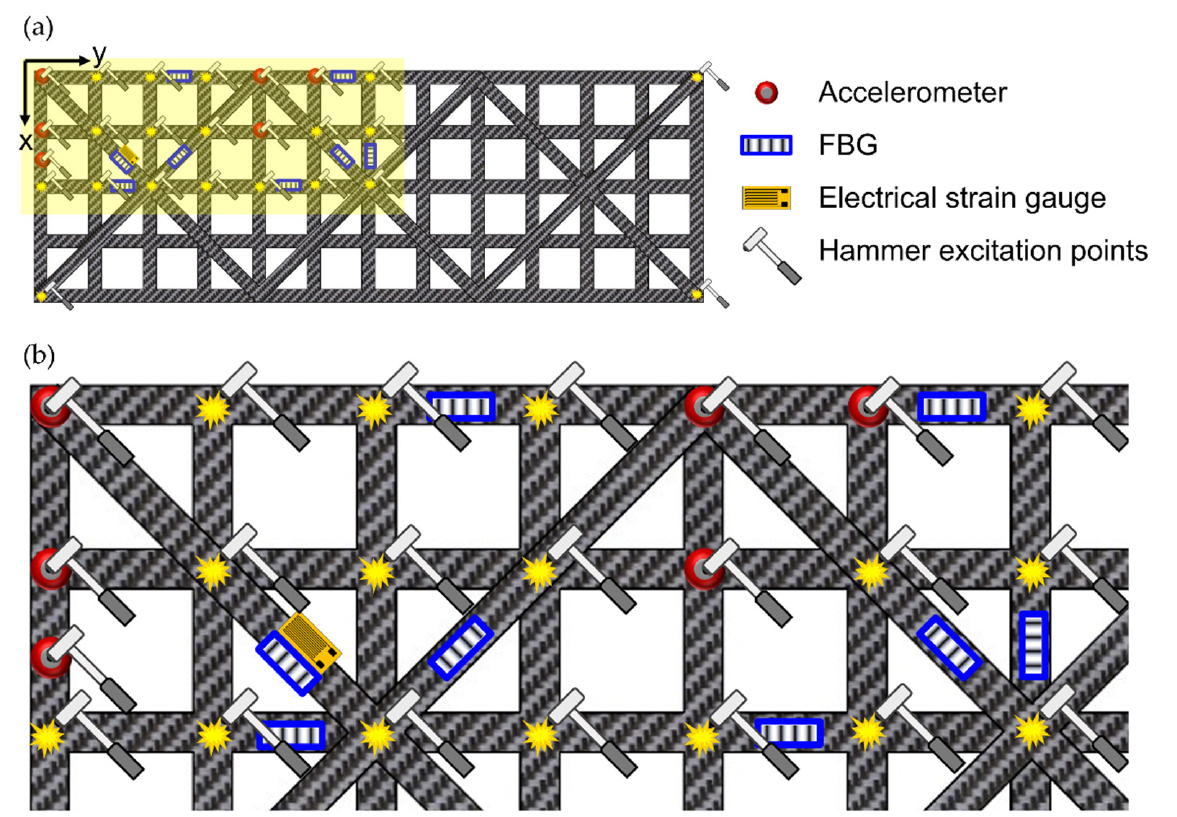
Figure 4. Sensor and hammer excitations: global view ( a ) and zoom view of the north-west corner ( b ).